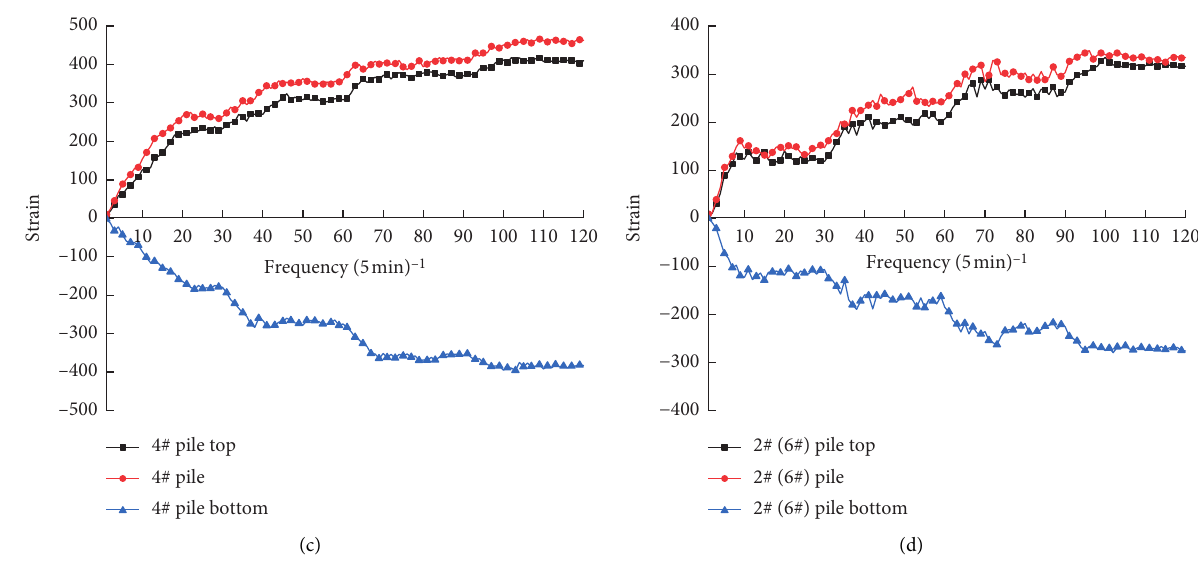
Figure 14: Pile stress distribution curves. (a) Pile #1, (b) pile #3, (c) pile #4, and (d) pile